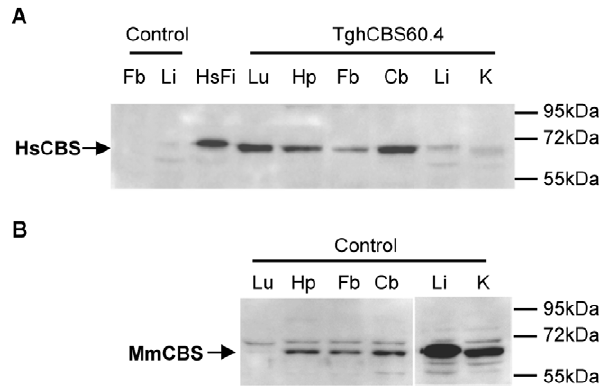
Figure 2. Western blot analysis of CBS expression in Tg hCBS 60.4 and control mouse tissues. Lu=Lung, Hp=Hippo- campus, Fb=Forebrain, Cb=Cerebellum, Li=Liver, K=Kidney. (A) The human 63-kDa CBS protein (HsCBS) was detected using the anti- NH 2 hCBS polyclonal antibody. Human specificity of the antibody was assessed by the absence of immunoreactivity with control mouse tissues (liver and forebrain) and immunoreactivity with cultured human fibroblasts (HsFi). (B) The mouse 63-kDa CBS protein (MmCBS) was detected using the anti-hCBS polyclonal antibody. Coomassie blue staining was used as a loading control (Figure S1).